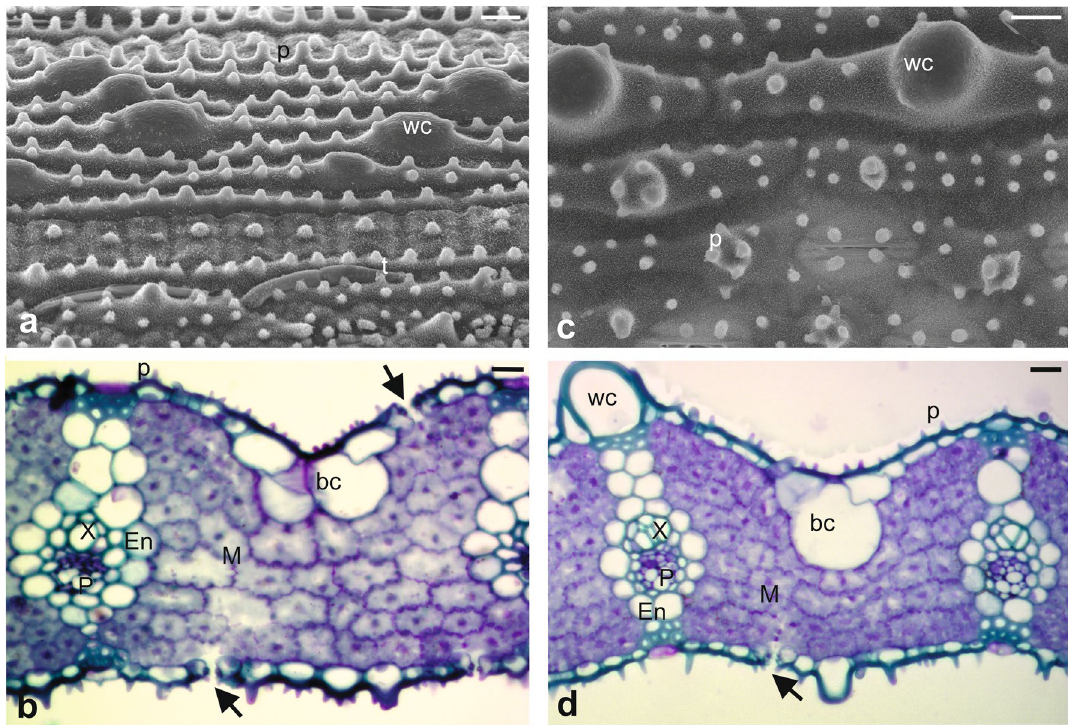
Figure 2. Leaf anatomy of rice cultivars resistant [‘Dawn’ = ( a ), ( b )] and susceptible [(‘BRS Pampa CL’ = ( c ), ( d )] to the South American rice water weevil Oryzophagus oryzae at 25 days after flooding (DAF). ( a ), ( c ) Scanning electron microscopy of the adaxial surface. ( b ), ( d ) Light microscopy (cross-section). M = mesophyll (mesophyll with chlorenchyma cells arranged densely packed); t = non-glandular trichome; p = papillae; wc = wart-like protuberant cell; bc = bulliform cells; X = xylem; P: phloem; En = endodermis; Arrows indicate stomata. Scale bars = ( a ) 10 µm [1000 ×], ( b ) 10 µm [1200 ×], ( c ), ( d ) 200